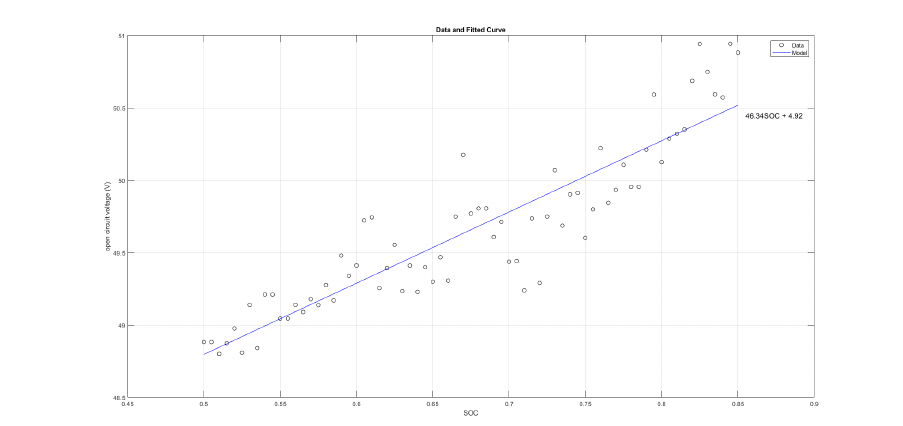
Figure 4. Battery equivalent circuit model.